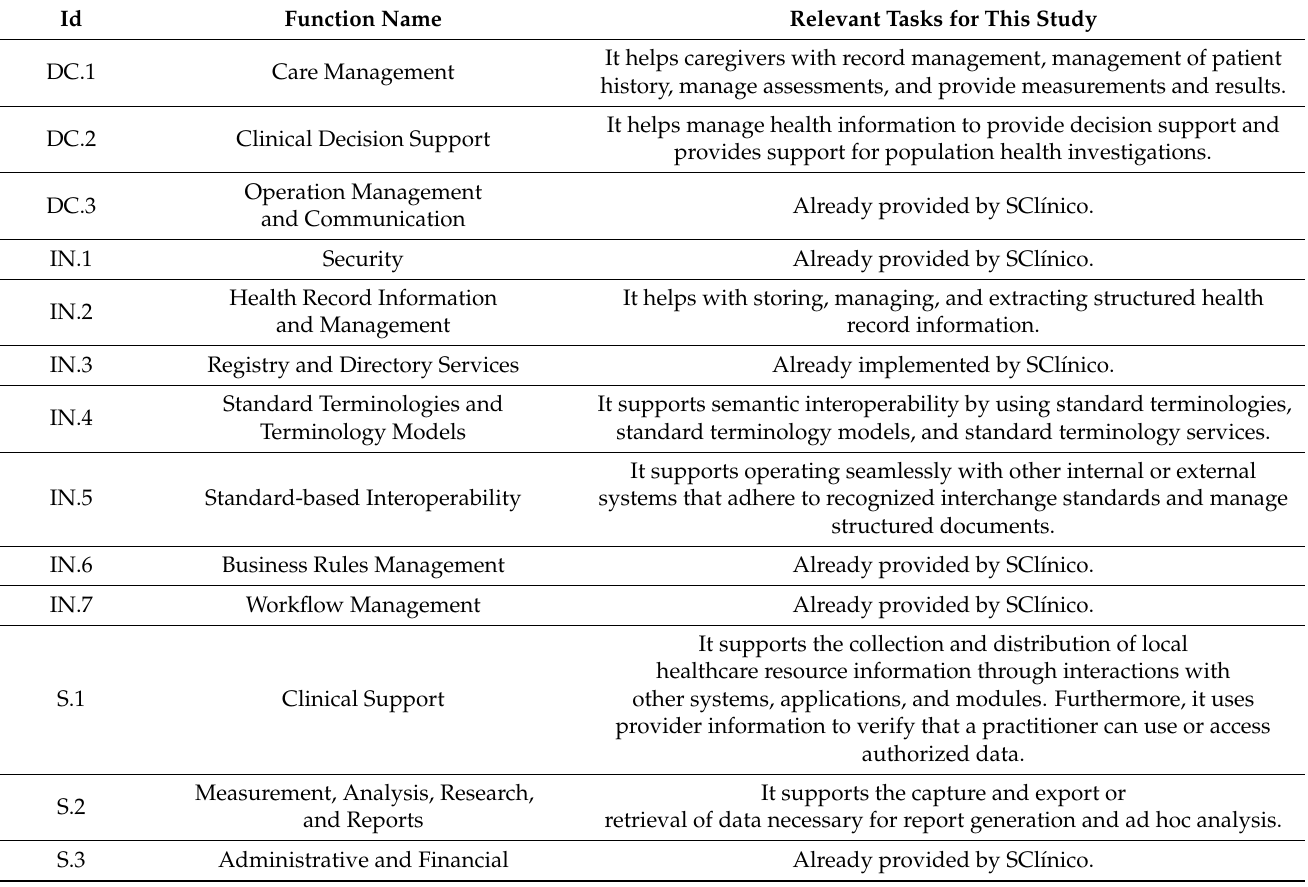
Table 1. Adopted function defined in EHR-S FM